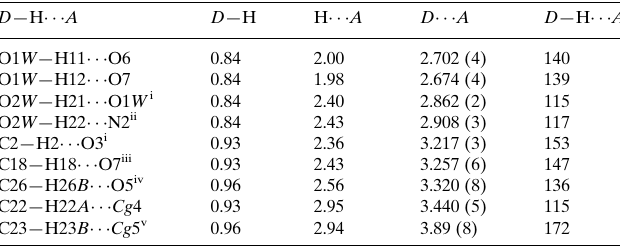
Hydrogen-bond geometry (A˚ , (cid:3) ). Cg 4 and Cg 5 are the centroids of the C1–C6 and C9–C14 rings,